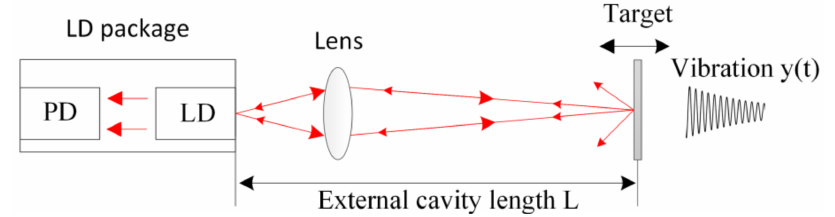
Figure 2. Schematic diagram of a typical free-space SMI